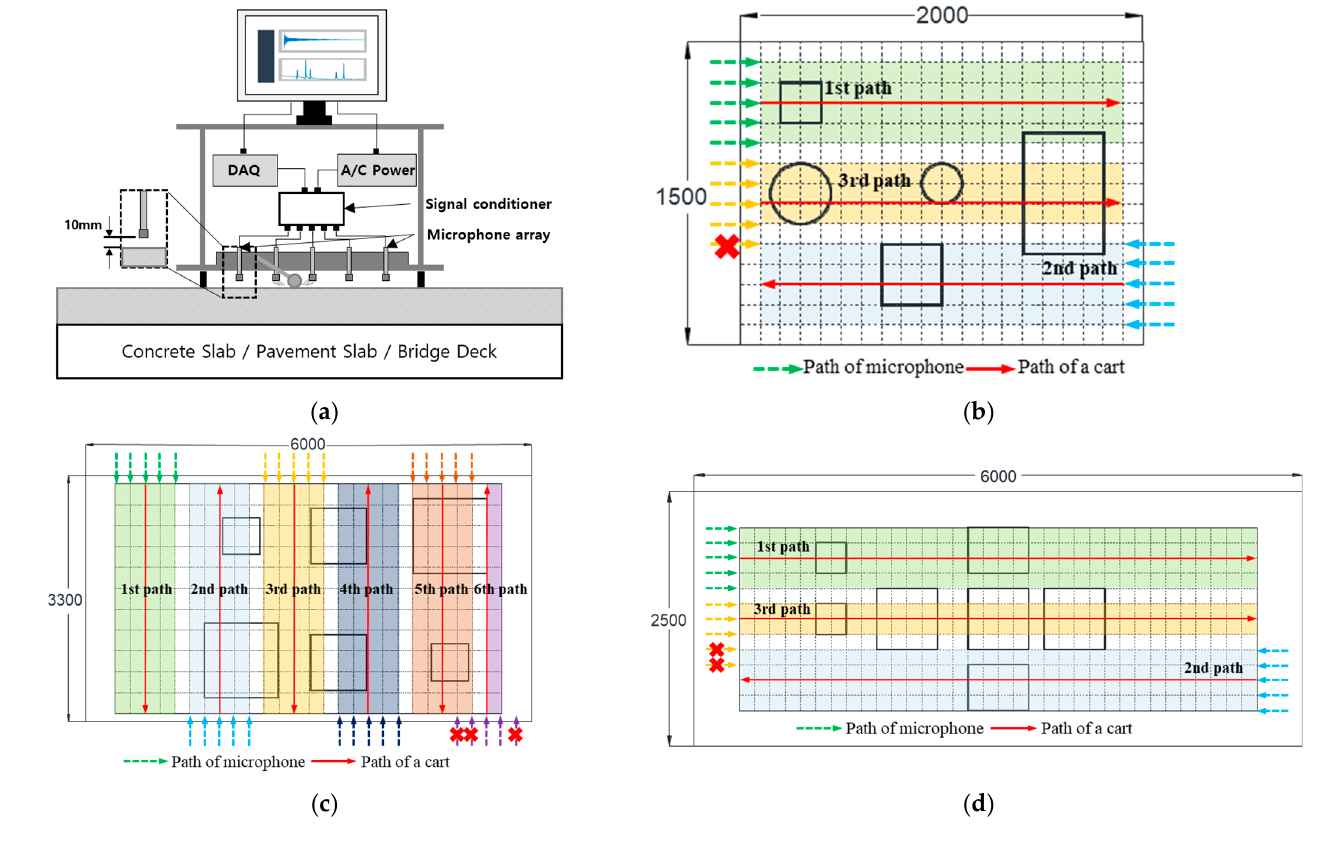
Figure 6. Test equipment and procedure: ( a ) test equipment; ( b ) test procedure for slab A; ( c ) test procedure for slab B; ( d ) test procedure for slab C.